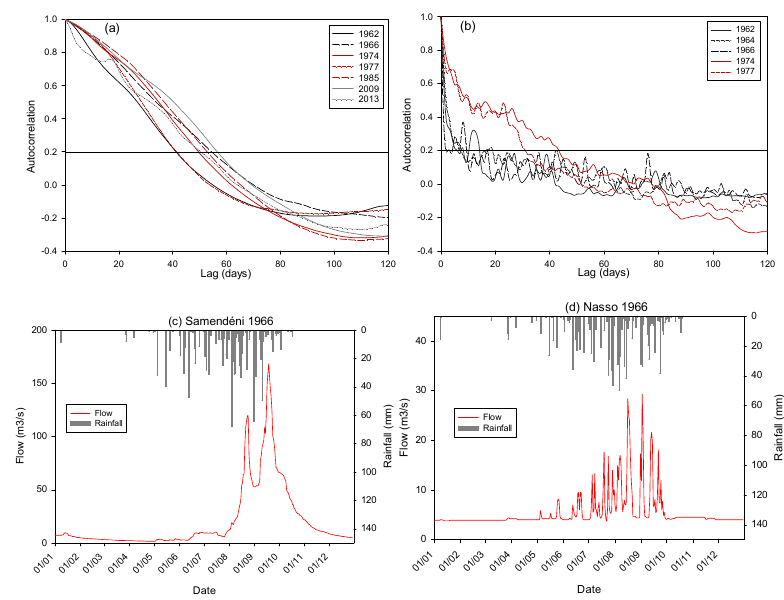
Figure 3. Autocorrelation of daily flows measured at ( a ) Samendéni; and ( b ) Nasso stations for different years; and ( c ) example of 1966 hydrograph measured at Samendéni; and ( d ) Nasso stations.